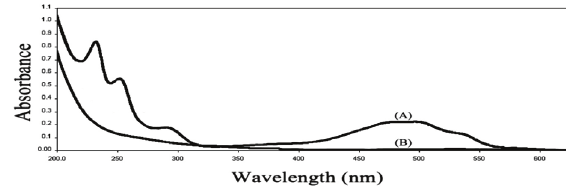
Figure 3: FTIR spectra of α-Fe support of SAPO-34(B).